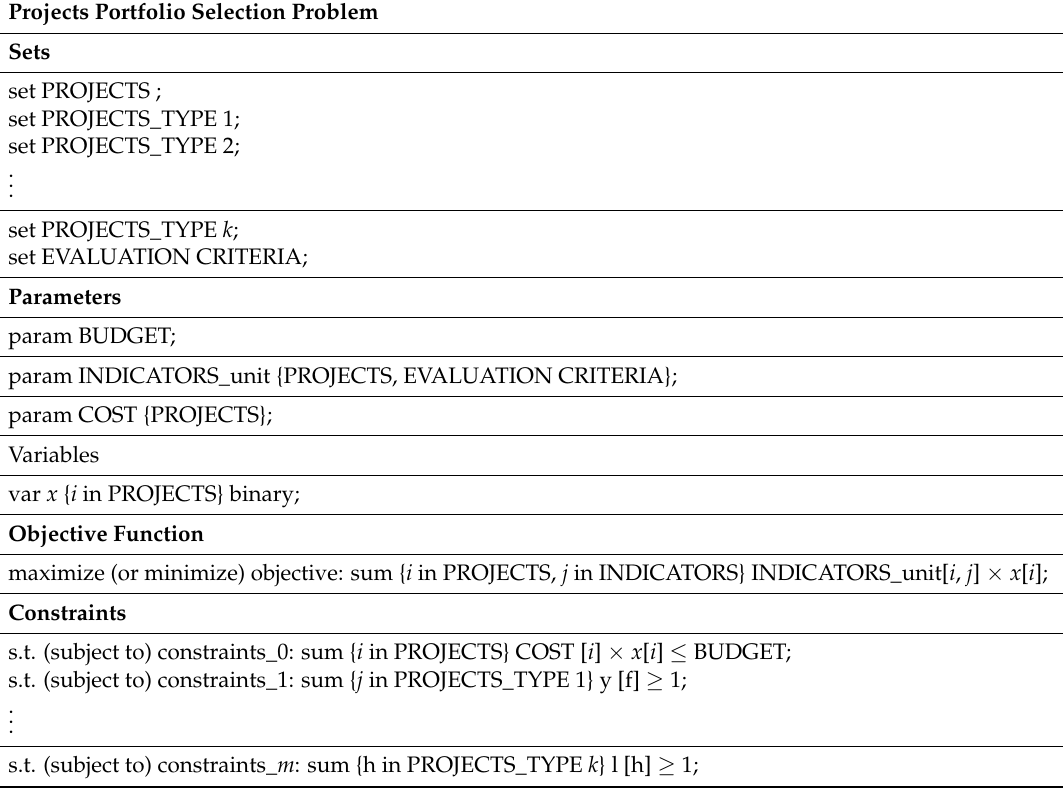
Table 2. Evaluation